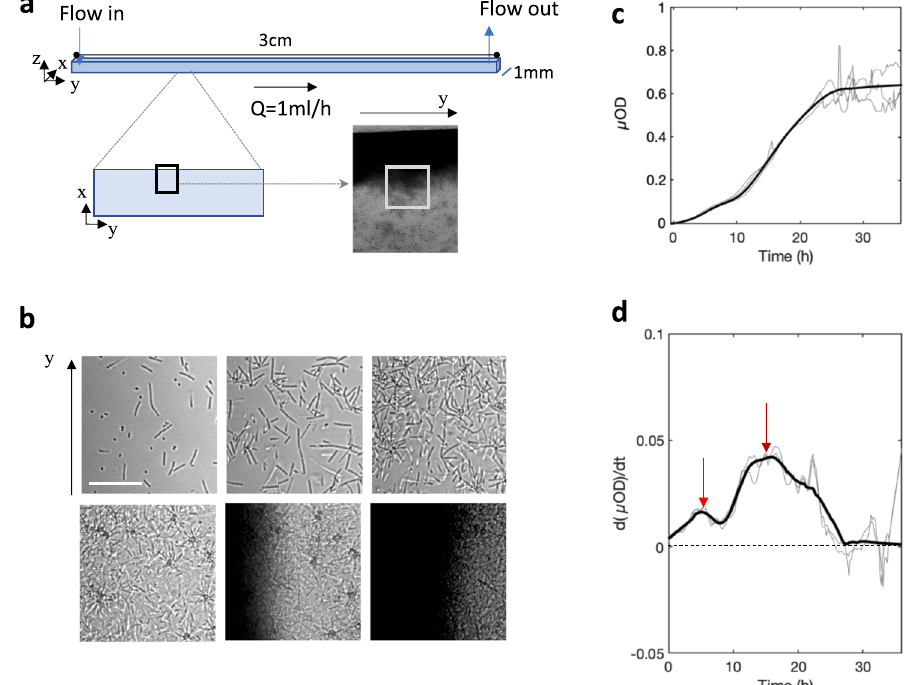
Fig. 1 4S bio fi lm growth under constant fl ow in the milli fl uidic channel. a A square channel (1 mm × 1 mm and 30 mm in length) continuously fed with growth medium at 1 mL/h was positioned on a microscope stage thermostatically maintained at 30 °C. Images of 0.15 µm 2 in size, covering nearly half of the width of the channel from the edge to the middle (black rectangle), were taken every 10 min. b Zoomed in images corresponding to the gray squares in a at time t = 10 min (left upper); 2h30 (center upper); 5 h (right upper); 18 h (left lower); 30 h (center lower); and 35 h (right lower), scale bar represents 30 µm ( c ). The µOD — calculated from transmitted light images, i.e., ln( I 0 / I ), and proportional to biomass — as a function of time. The intensity I is averaged over all of the pixels in the 0.15 µm 2 image (black frame in a ). d Derivative of the µOD signal with respect to time. The red arrows show maxima of the expansion rate. Light curves are from three independent biological replicates, and the bold curve is the smoothed